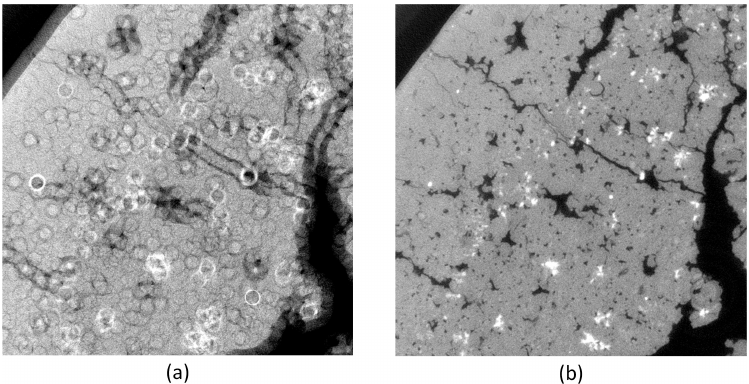
Figure 8. Detailed view of a tomogram (Cheese with salt particles): ( a ) Left image without rotation axis correction; ( b ) right image rotation axis corrected with − 15.2 pixels horizontal